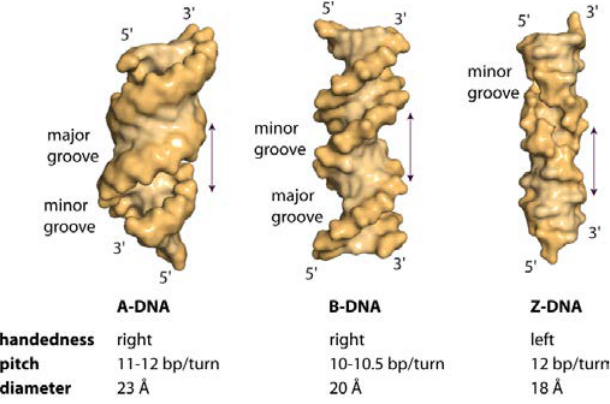
Figure 2. Surface representation of A-, B- and Z-DNA. Hexadecameric A- and B-DNA helices with alternating (ATGC) sequence were generated in COOT [13]. Z-DNA with the 4 sequence (GC) was constructed with 3DNA [14]. A-DNA is slightly unwound, possessing 8 a shallow, wide minor groove and a deep, narrow major groove. B-DNA features a narrow minor groove and a broad major groove. In the left-handed Z-DNA, named by the zig-zag pattern in the phosphodiester backbone, a deep minor groove is observed, while the major groove is reorganised and features a convex